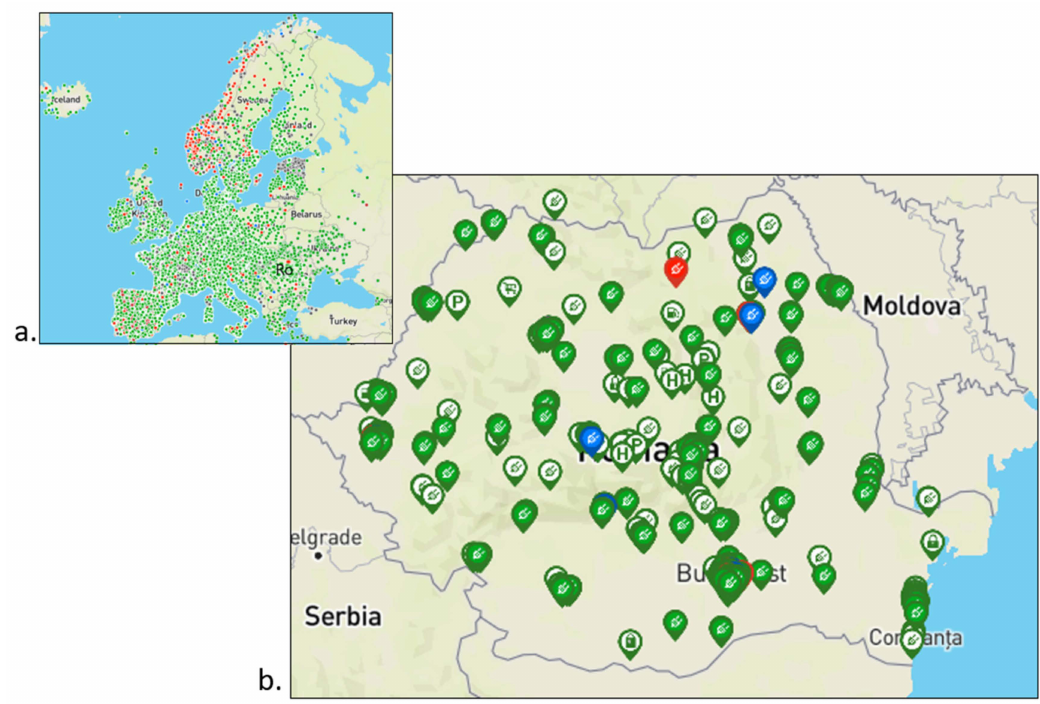
Figure 5. Charging stations for electric cars in cars in ( a ) Europe and in ( b ) Romania (614) in 2021 adapted by authors based on Electromaps